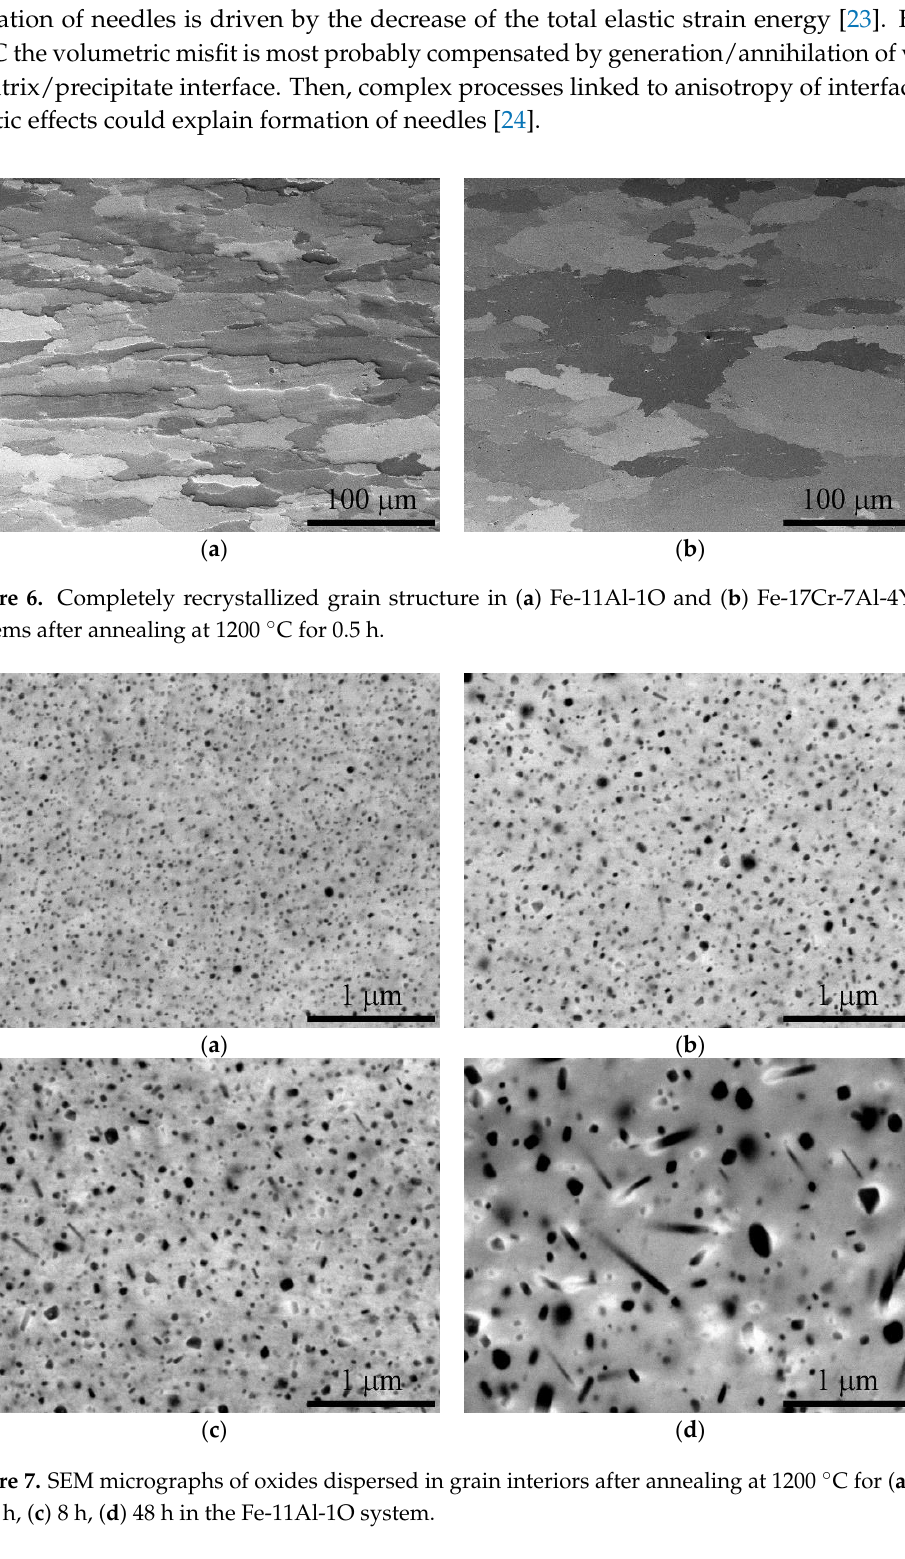
Figure 9. Note that during coarsening of oxides in the Fe-11Al-1O system, the shape of several large